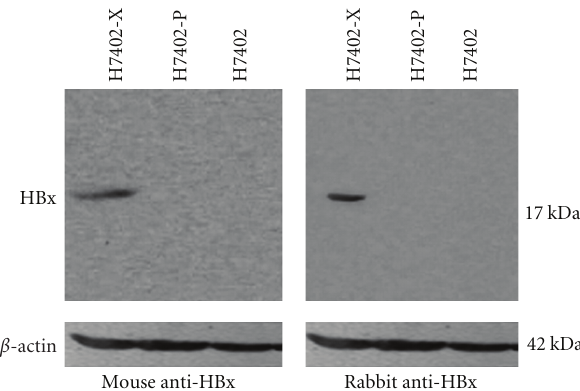
Figure 1: Identification of rabbit anti-HBx polyclonal antibody. HBx in H7402-X, H7402-P, and H7402 cells was examined by Western blot analysis, using generated rabbit anti-HBx polyclonal antibody and mouse anti-HBx monoclonal antibody, respectively. The results showed that the generated rabbit anti-HBx polyclonal antibody was e ff ectively able to recognize HBx in H7402-X cells as mouse anti-HBx monoclonal antibody did.